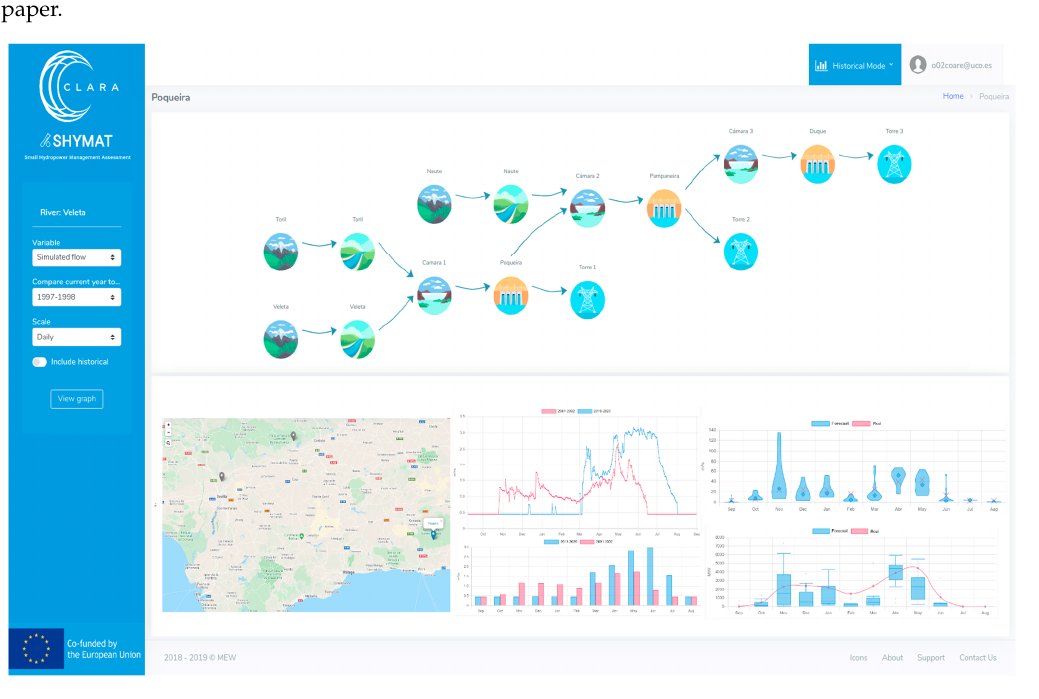
Figure A1. Example of some details of the web user interface of the climate service SHYMAT, showing the topological panel, the geolocation map and graphs of the water availability and operation